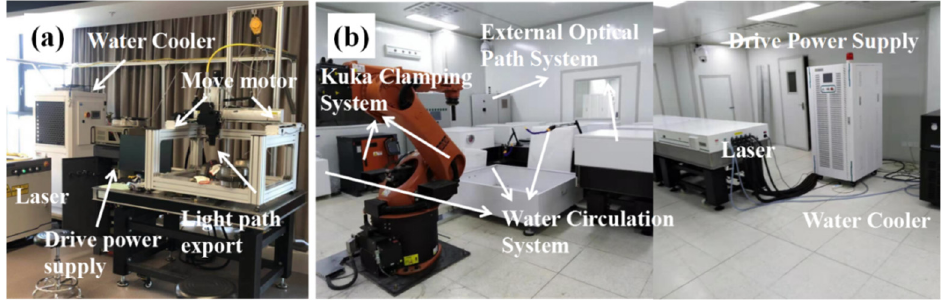
Figure 1. Surface strengthening equipment—( a ) laser-processing drive control all-in-one system; ( b ) equipment system for laser shock peening.